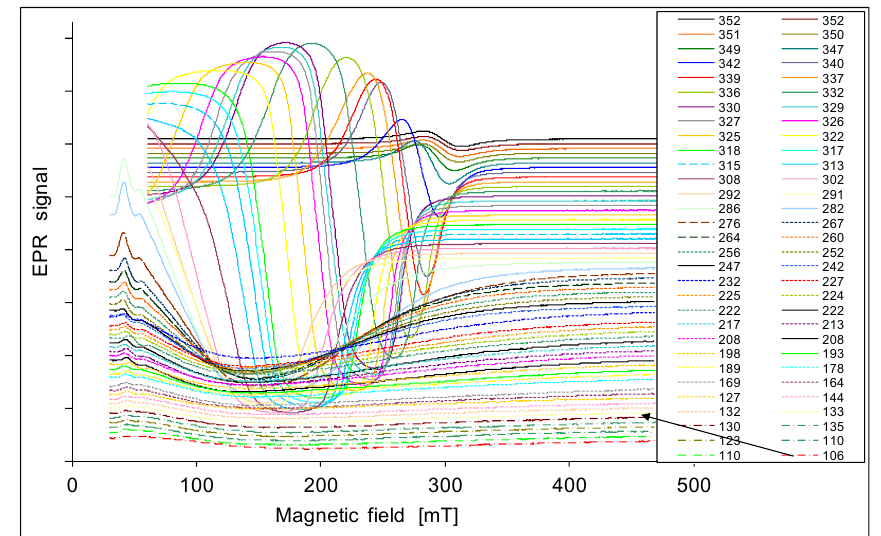
Figure 3. EPR spectra of the sample 3p at various temperatures in K.